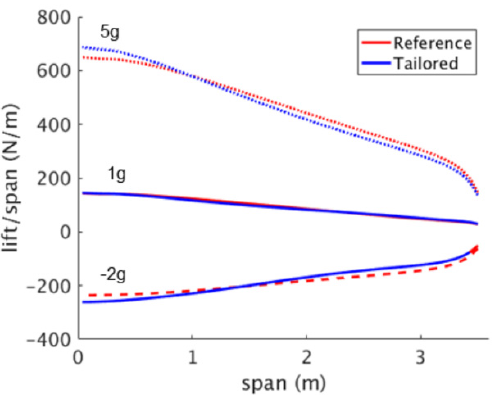
Figure 7. Span-wise lift distribution in the reference and tailored wings for different manoeuvre loads.